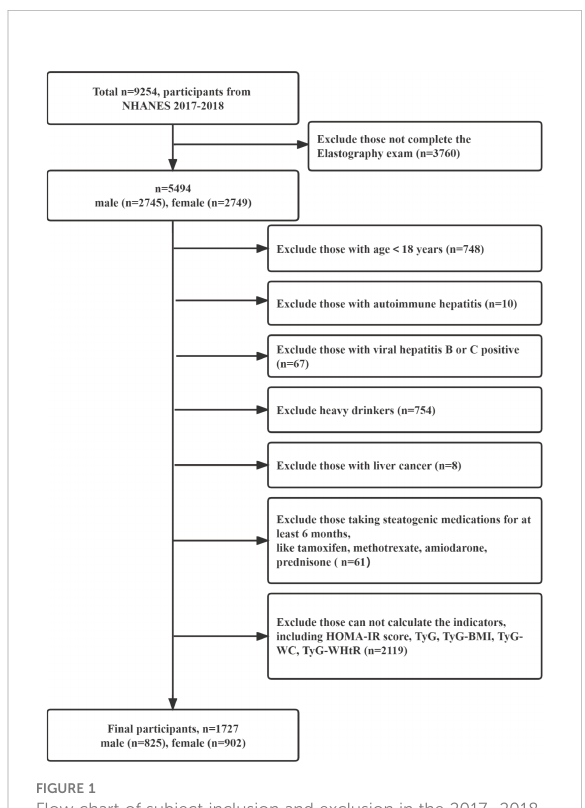
FIGURE 1 Flow chart of subject inclusion and exclusion in the 2017 – 2018 U.S. National Health and Nutrition Examination